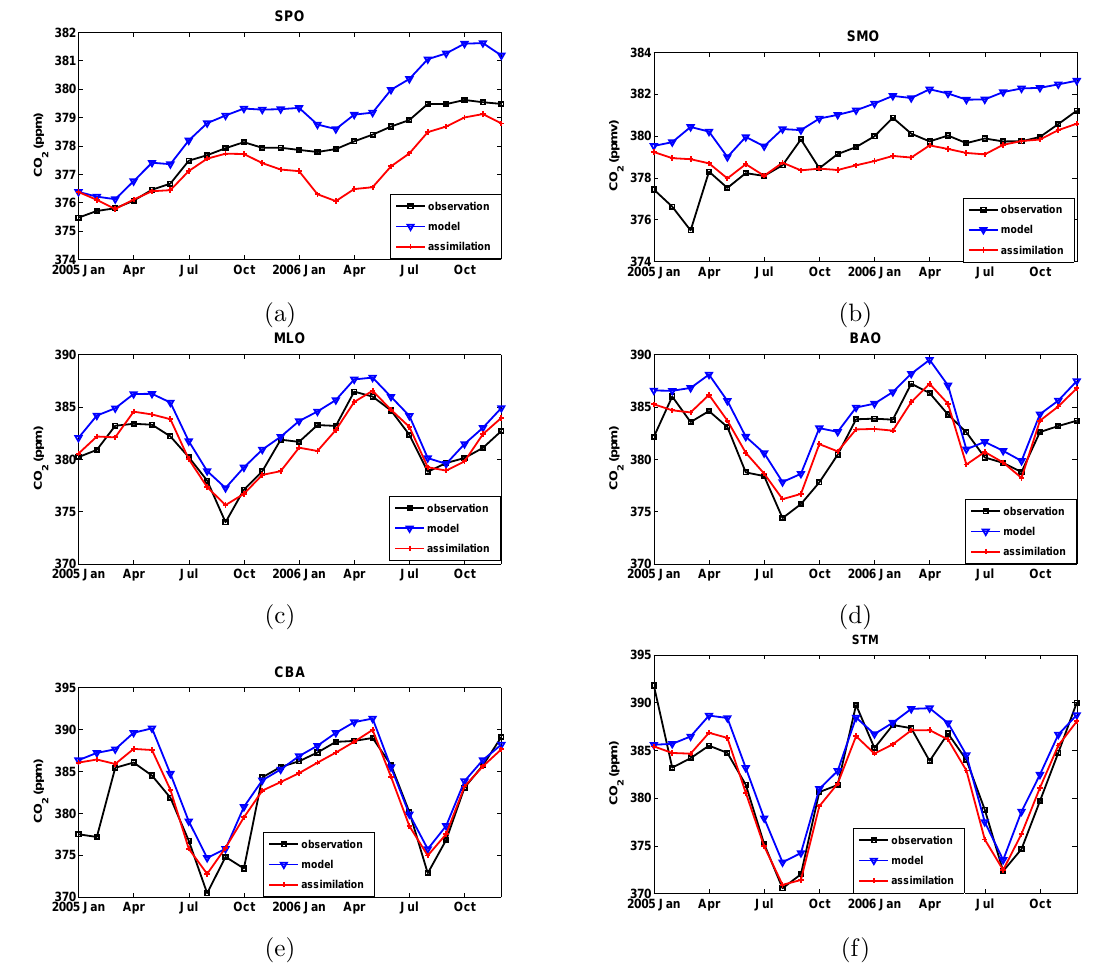
Figure 4: Monthly mean CO 2 from NOAA/ESRL/GMD cooperative air sampling network (black), GEOS-5 interpolated to the observation locations, for simulations (blue) and with AIRS data assimilated (red). The sites used here are (a) SPO (89.96 ◦ S, 24.8 ◦ W), (b) SMO (14.25 ◦ S, 170.56 ◦ W), (c) MLO (19.5 ◦ N, 155.6 ◦ W), (d) BAO (40.0 ◦ N, 105.0 ◦ W), (e) CBA (55.2 ◦ N, 162.7 ◦ W), (f) STM (66 ◦ N, 2 ◦ N).